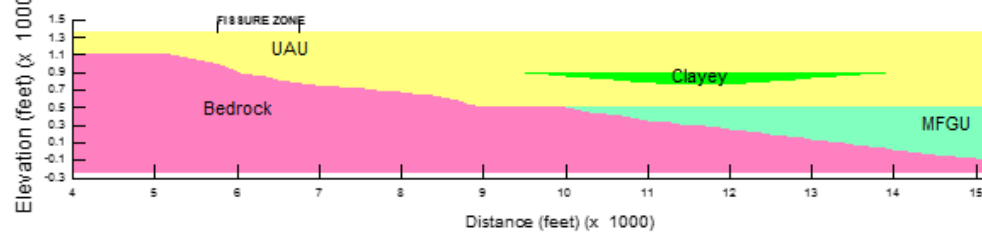
Figure 1. Finite Element Model Geometry along McMicken Dam.